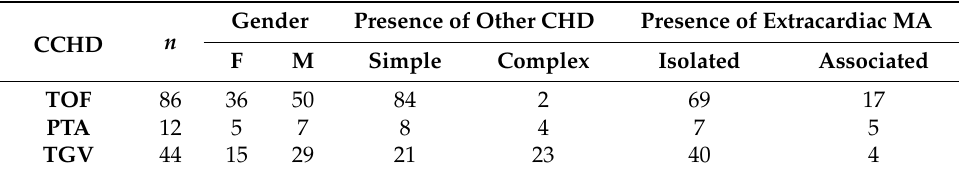
Table 1. Distribution of different CCHD types by gender, presence of other CHD and major extracardiac anomalies among